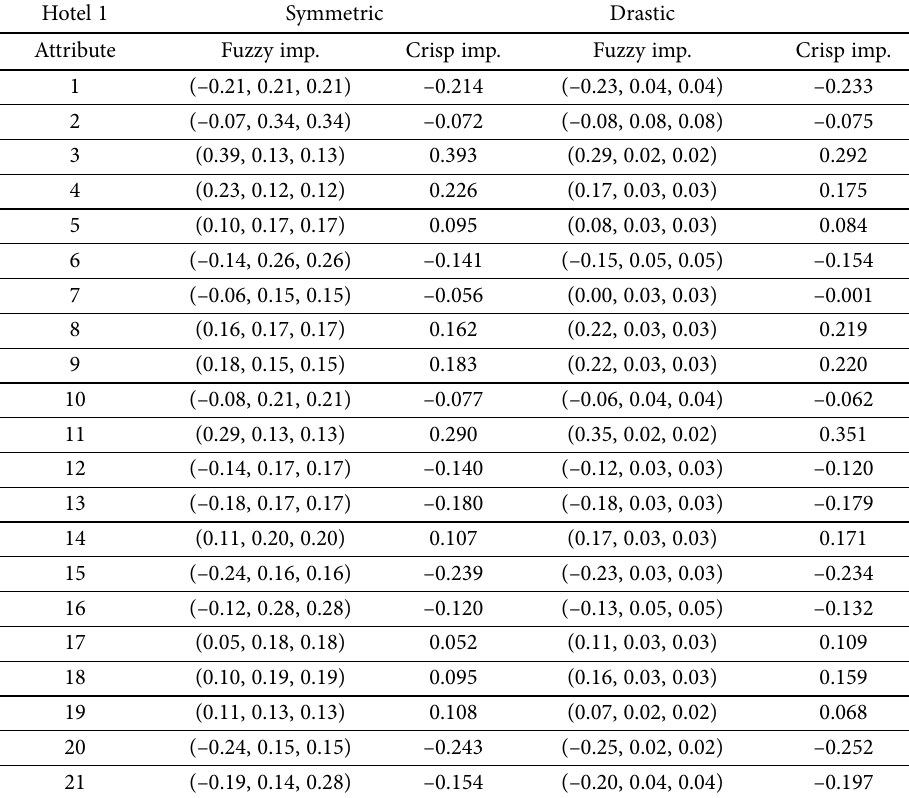
Table 6. Fuzzy importance and crisp importance of attributes – Hotel